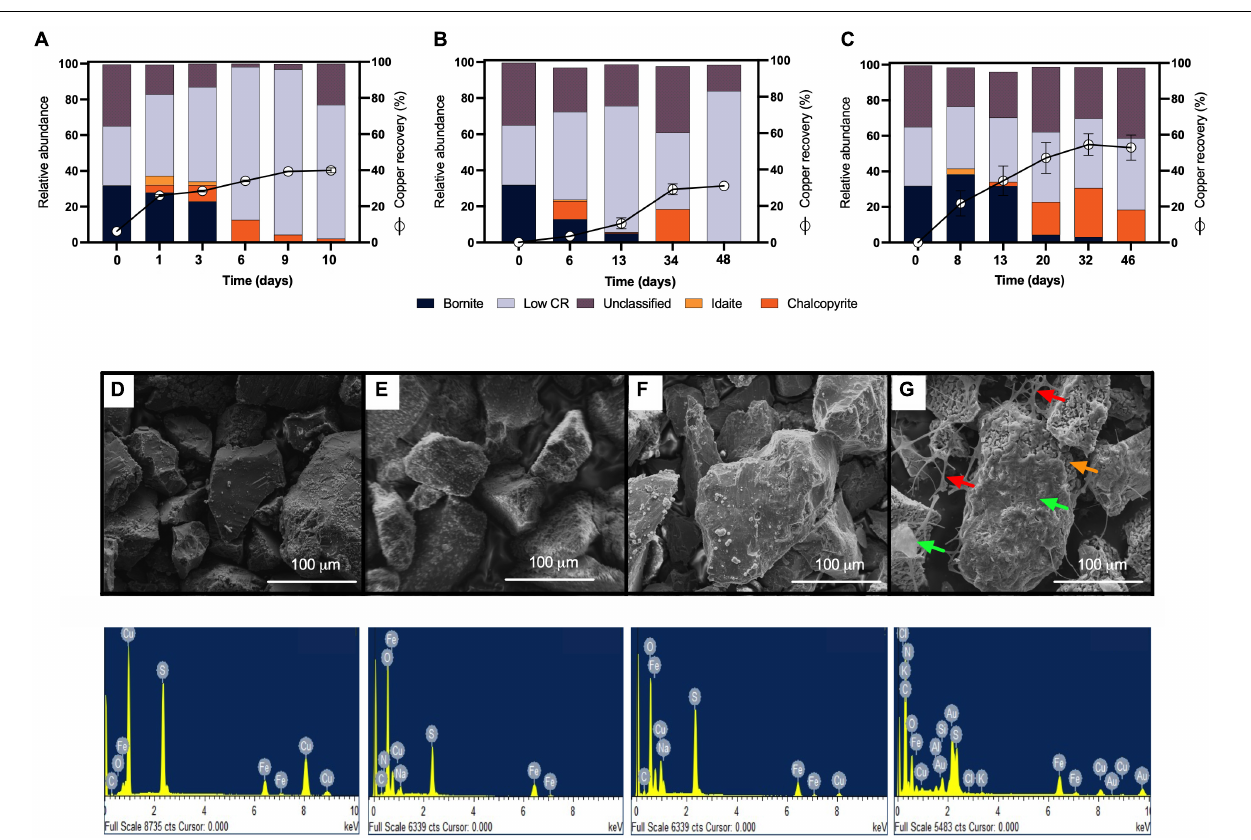
FIGURE 3 | Mineralogical dynamics, SEM images, and EDS spectra of high-purity natural bornite bioleaching under mesophilic (30 ◦ C) inoculation. (A) Turbulent flow bioleaching with addition of ferric iron (screening method), (B) turbulent flow bioleaching with addition of ferrous iron (screening method), (C) laminar flow bioleaching (flow cell method). SEM images and EDS spectra for (D) bornite before bioleaching, (E) bornite after 10 days (40% Cu recovery) under turbulent flow mesophilic bioleaching (screening method), (F) bornite after 48 days (30% Cu recovery) under turbulent flow mesophilic bioleaching with addition of ferrous iron (screening method), (G) bornite after 46 days (54% Cu recovery) under laminar flow mesophilic bioleaching (flow cell method). Red, orange, and green arrows indicate exopolysaccharide (EPS) network, altered mineral, biofilm formation, respectively. Low CR: no mineral